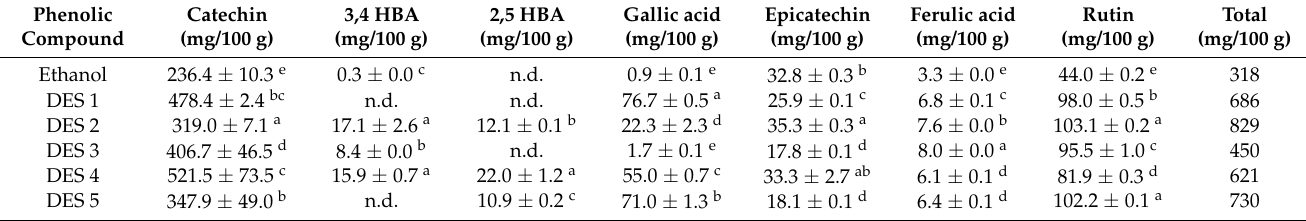
Table 2. Individual phenolic compounds identified and quantified in the extracts from avocado peel obtained with DES and